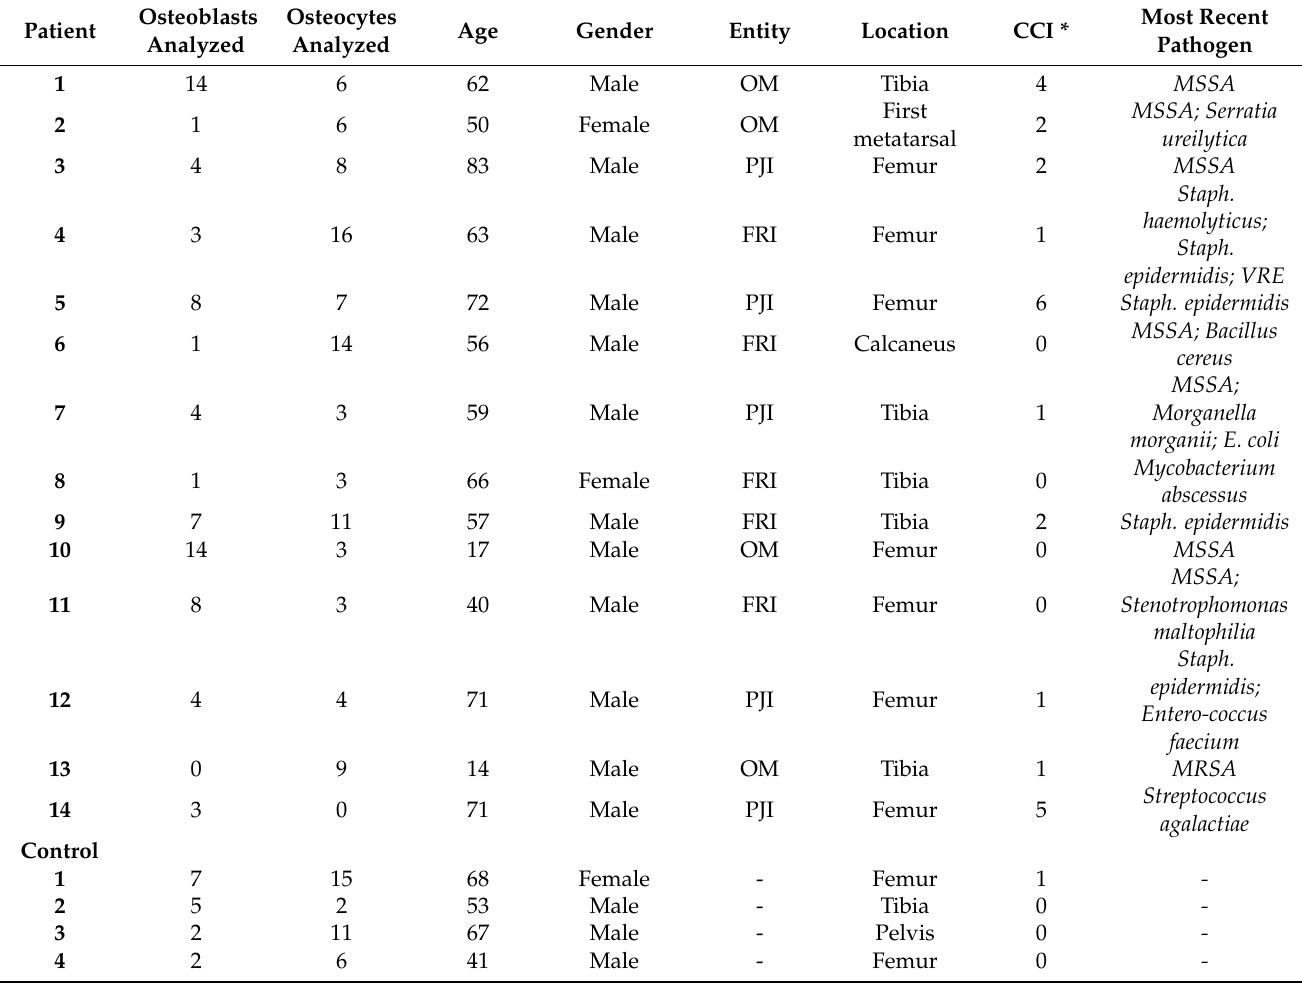
Table 1. List of included